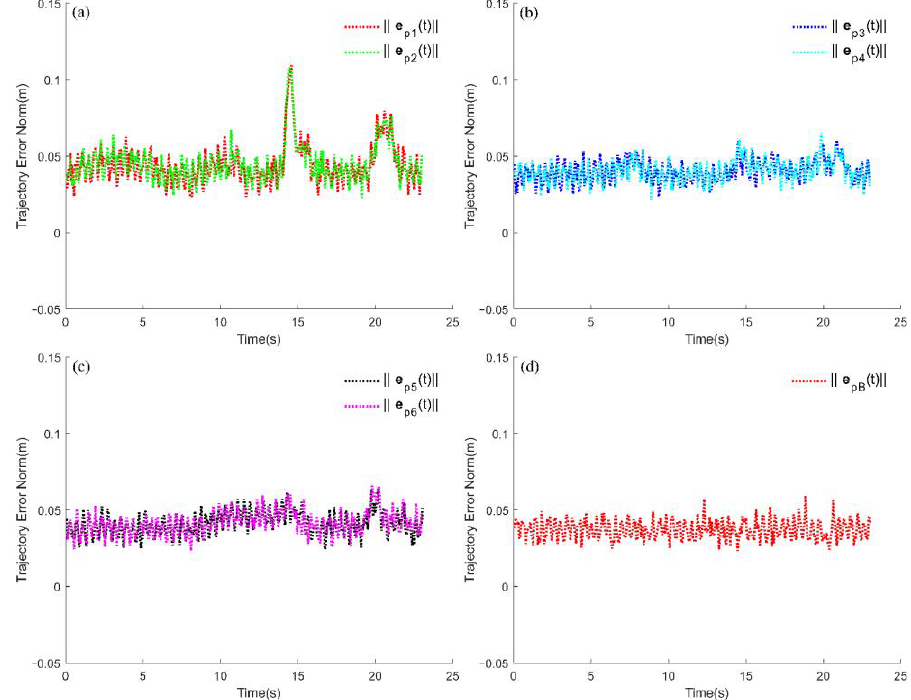
Figure 13. Trajectory error norm of tracked robot through trench terrain. Subfigure ( a ) indicates the error norms of the front flipper. Subfigure ( b ) indicates the error norms of the middle flipper. Subfigure ( c ) indicates the error norms of the rear flipper. Subfigure ( d ) indicates the error norm of the center of mass.